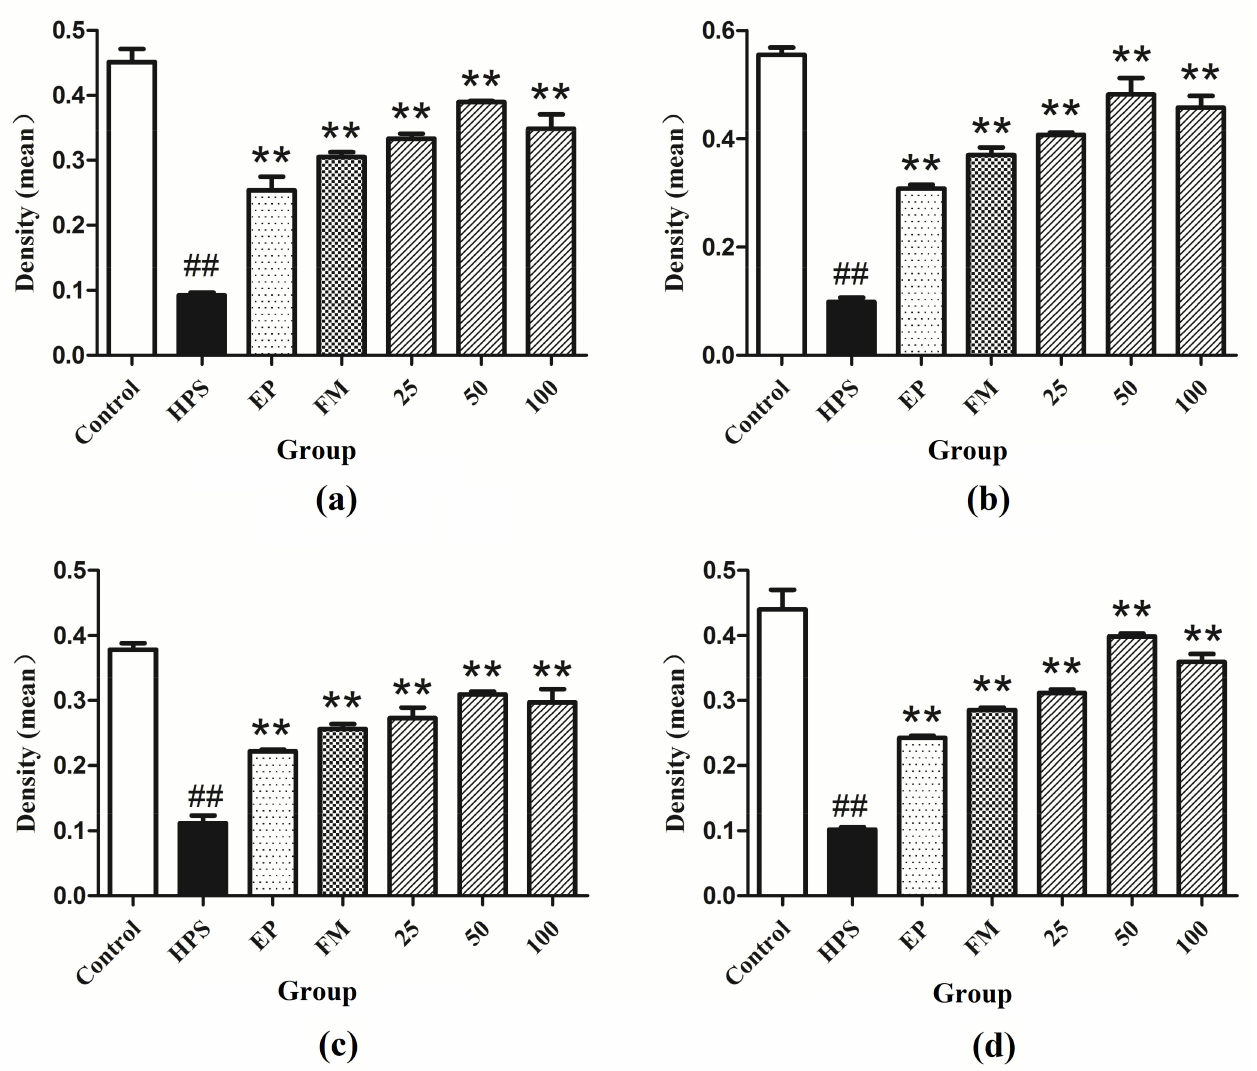
Figure 6. Fluorescence of ( a ) occludin, ( b ) ZO-1, ( c ) claudin-1 and ( d ) JAM-1 in peritoneum were measured by densitometric analysis using the software Image J. HPS: G. parasuis group, EP:EP + G. parasuis group, FM:FM + G. parasuis group, 25:25 mg/kg baicalin + G. parasuis group, 50:50 mg/kg baicalin + G. parasuis group, 100:100 mg/kg baicalin + G. parasuis group. ## p < 0.01 vs. control. and ** p < 0.01 vs. G. parasuis